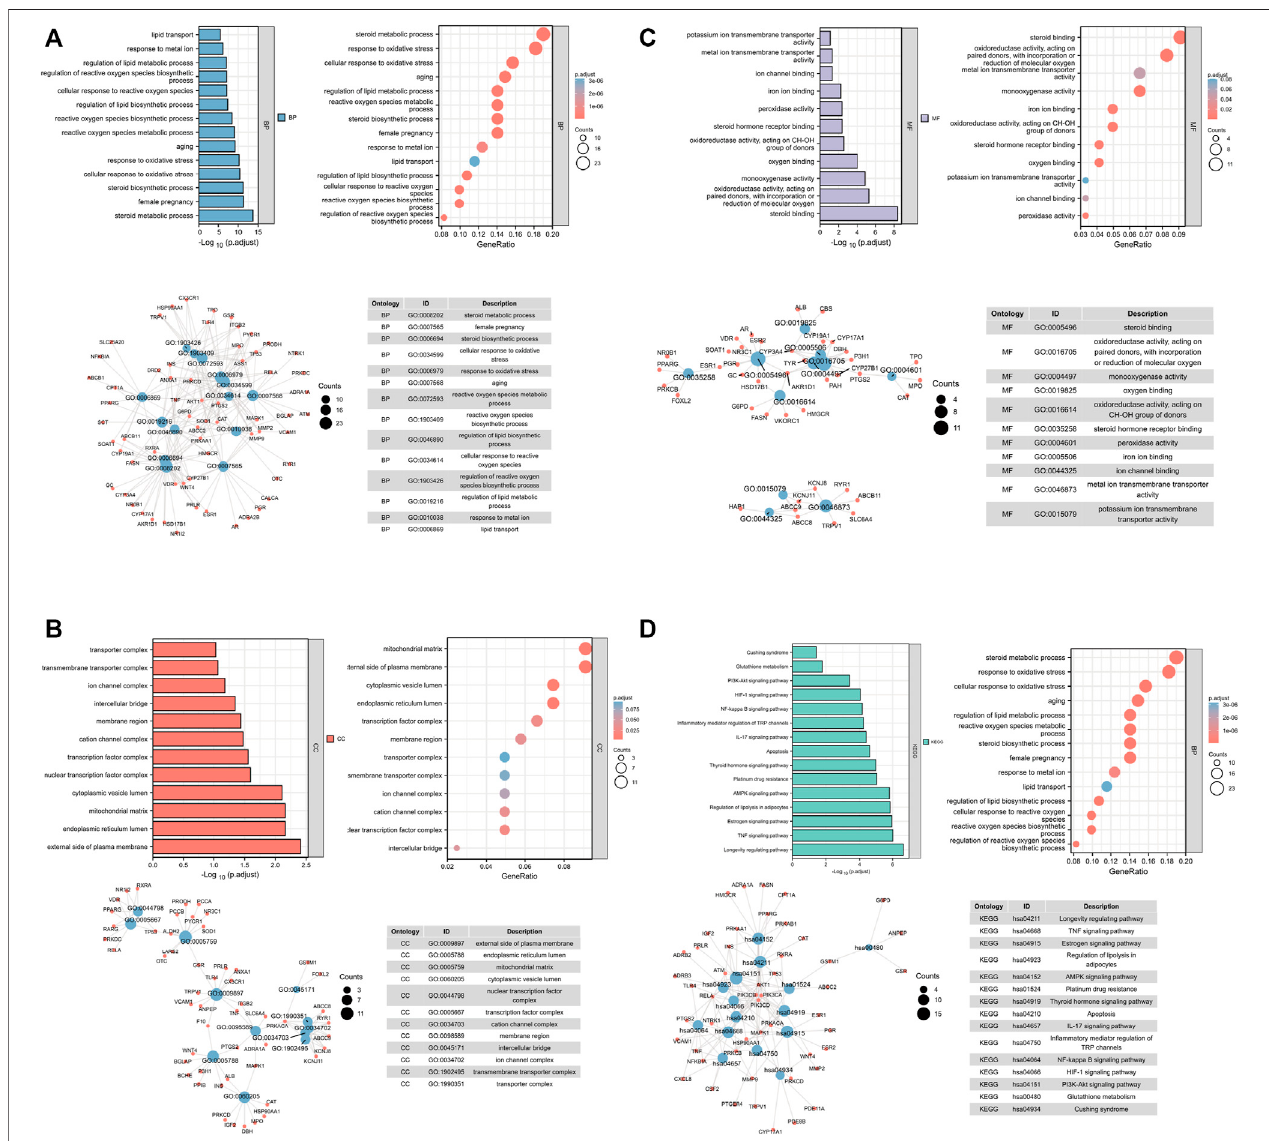
FIGURE1| Analysisofcommon target genesbyGOandKEGG. (A) BP. (B) CC. (C) MF. (D) KEGG. Left-up panelshowsthe p -valueofcurrentitems,theright-up shows the gene ratio of current items, the left-bottom shows the interaction between current items, and the right-bottom shows the detailed list of current